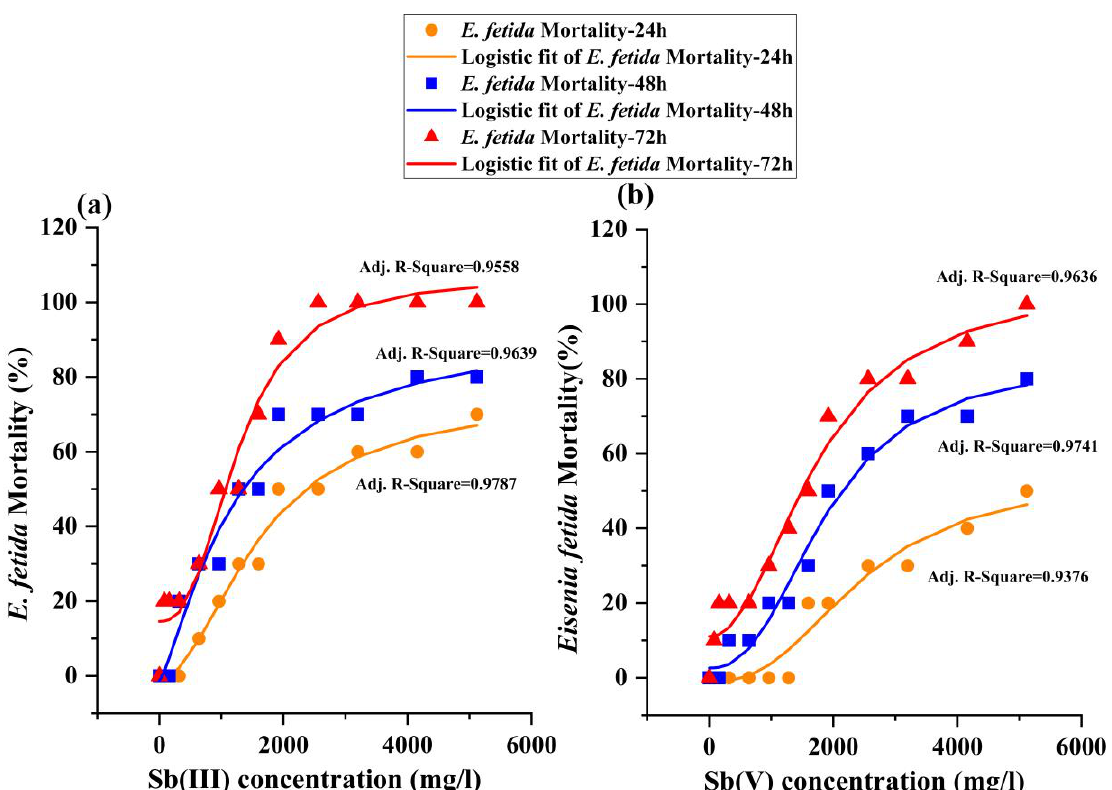
Figure 1. Mortality dose–response curves of E. fetida exposed to Sb (III) ( a ) and Sb (V) ( b ) for 24, 48, and 72 h by a filter paper contact toxic test. The Sb (III) and Sb (V) concentrations were prepared as 0, 80, 160, 320, 640, 960, 1280, 1600, 1920, 2560, 3200, 4160, and 5120 mg/L.